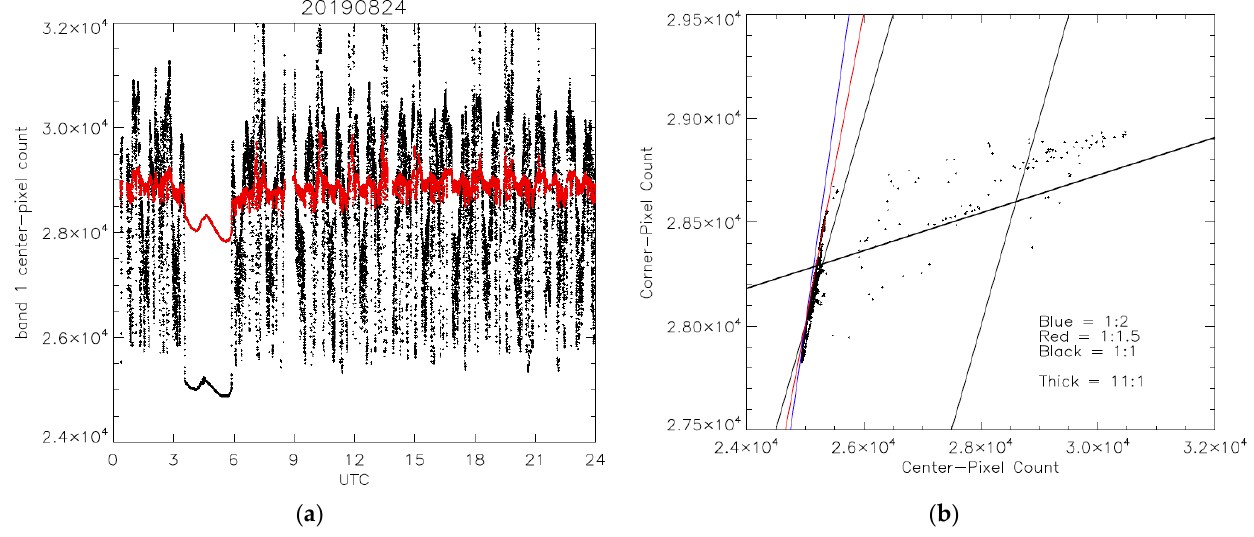
Figure A3. ( a ) Time series of CTI band1 count measurements from the center (160, 128) and corner (2, 2) pixels in in black and red, respectively; ( b ) correlation of the center and corner pixel count measurements from multiple ISS pitch-up/down maneuvers. Various slopes are plotted to guide visual comparisons. Neither deep-space nor Earth views showed that the center and corner pixel measurements followed a 1:1 relationship. All space-view counts were in a tight cluster with a robust linear relationship (i.e., a 1:1.5 slope), regardless of the pitch-up/down date. Data points with center-pixel counts greater than 2.55 × 10 5 had significant contributions from the atmosphere and were therefore excluded in developing the CTI background model (Equation (A2)).